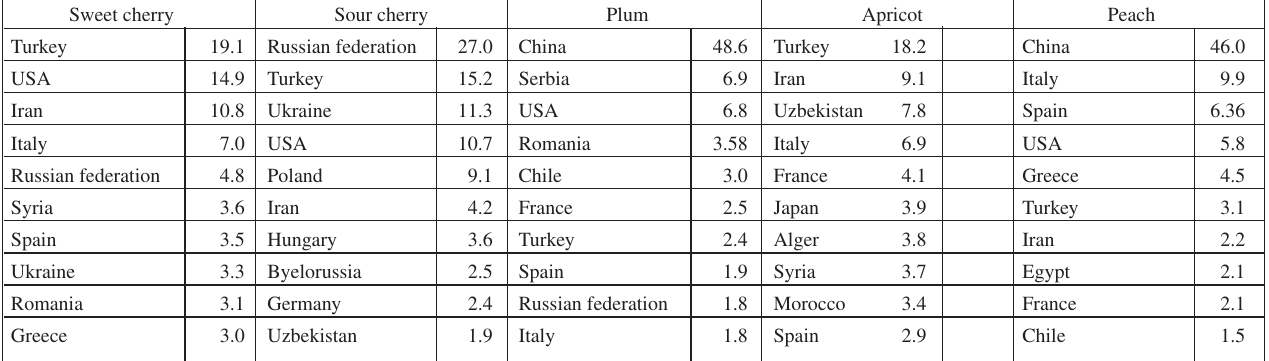
Table 2. Main producers of stone-fruits and their rate in 2007 (%)